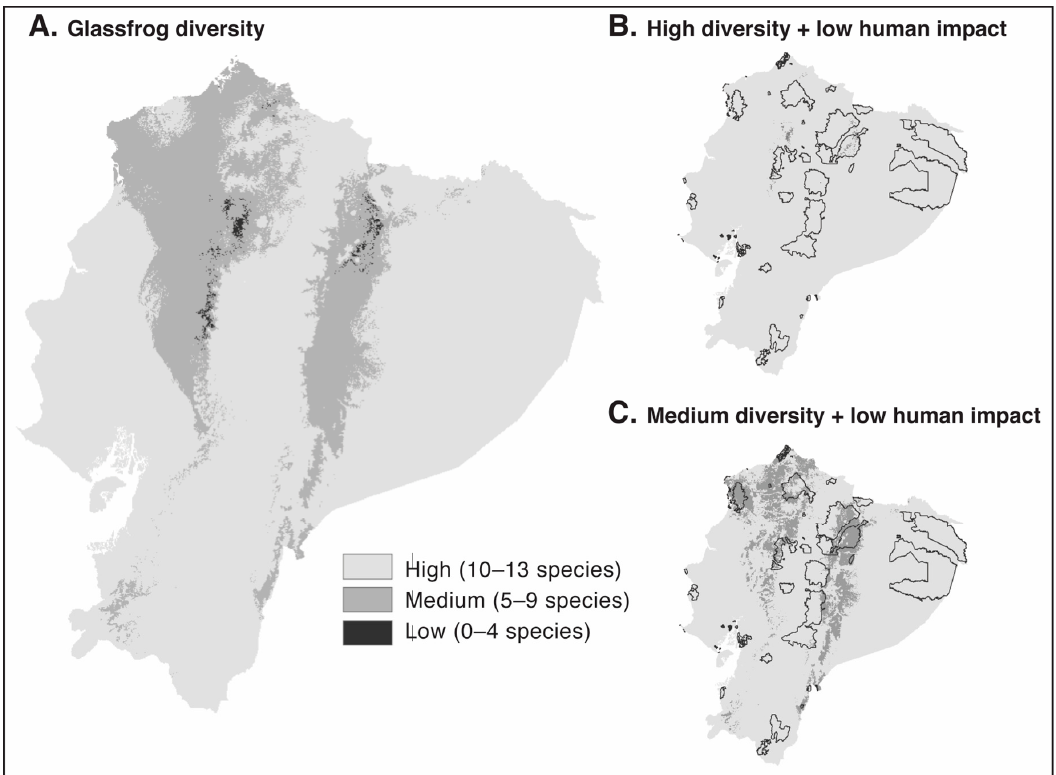
Figure 237. Glassfrog species diversity in Ecuador. ( A ) Species diversity simplified into three categories: High, medium, and low. ( B ) Map showing protected areas in Ecuador and, in dark, regions that combine high glassfrog diversity and low impact by human activities. ( C ) Map showing protected areas in Ecuador and, in dark, regions with both medium diversity and low impact by human activities.